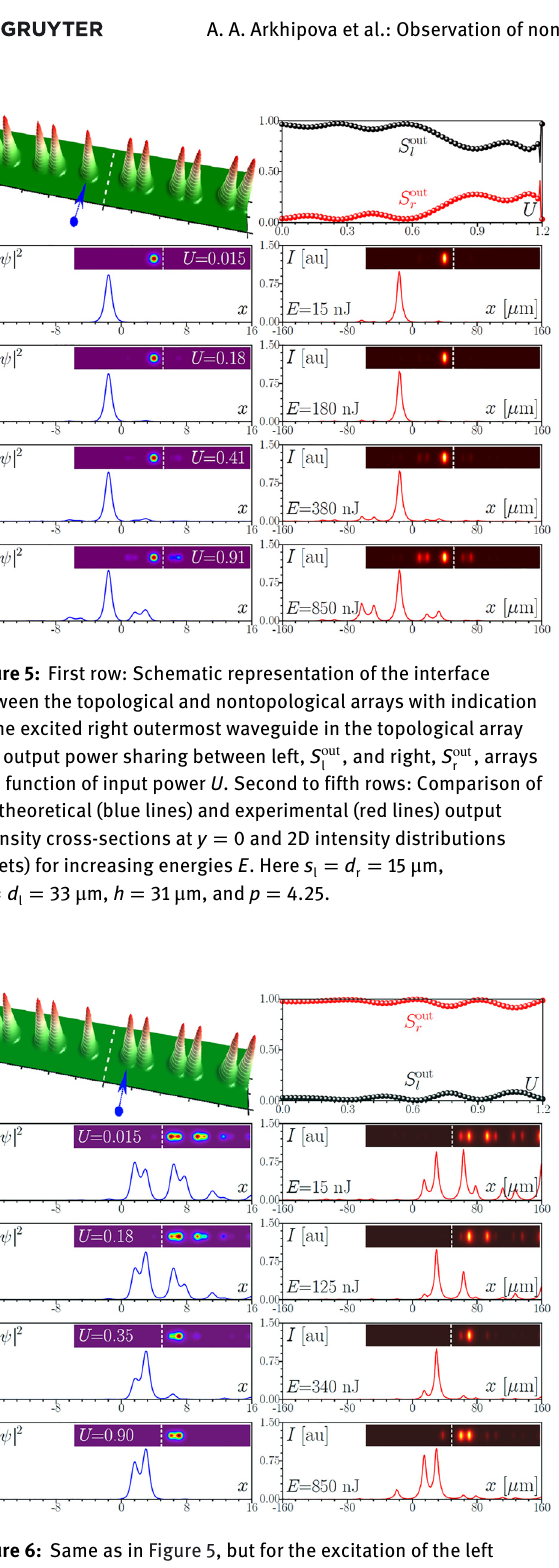
column).Atsufficientlyhighpulseenergiesoftheorderof E ∼ 400nJ, light shrinks to a pair of close waveguides at the edge of the nontopological array and undergoes periodic oscillations between these two